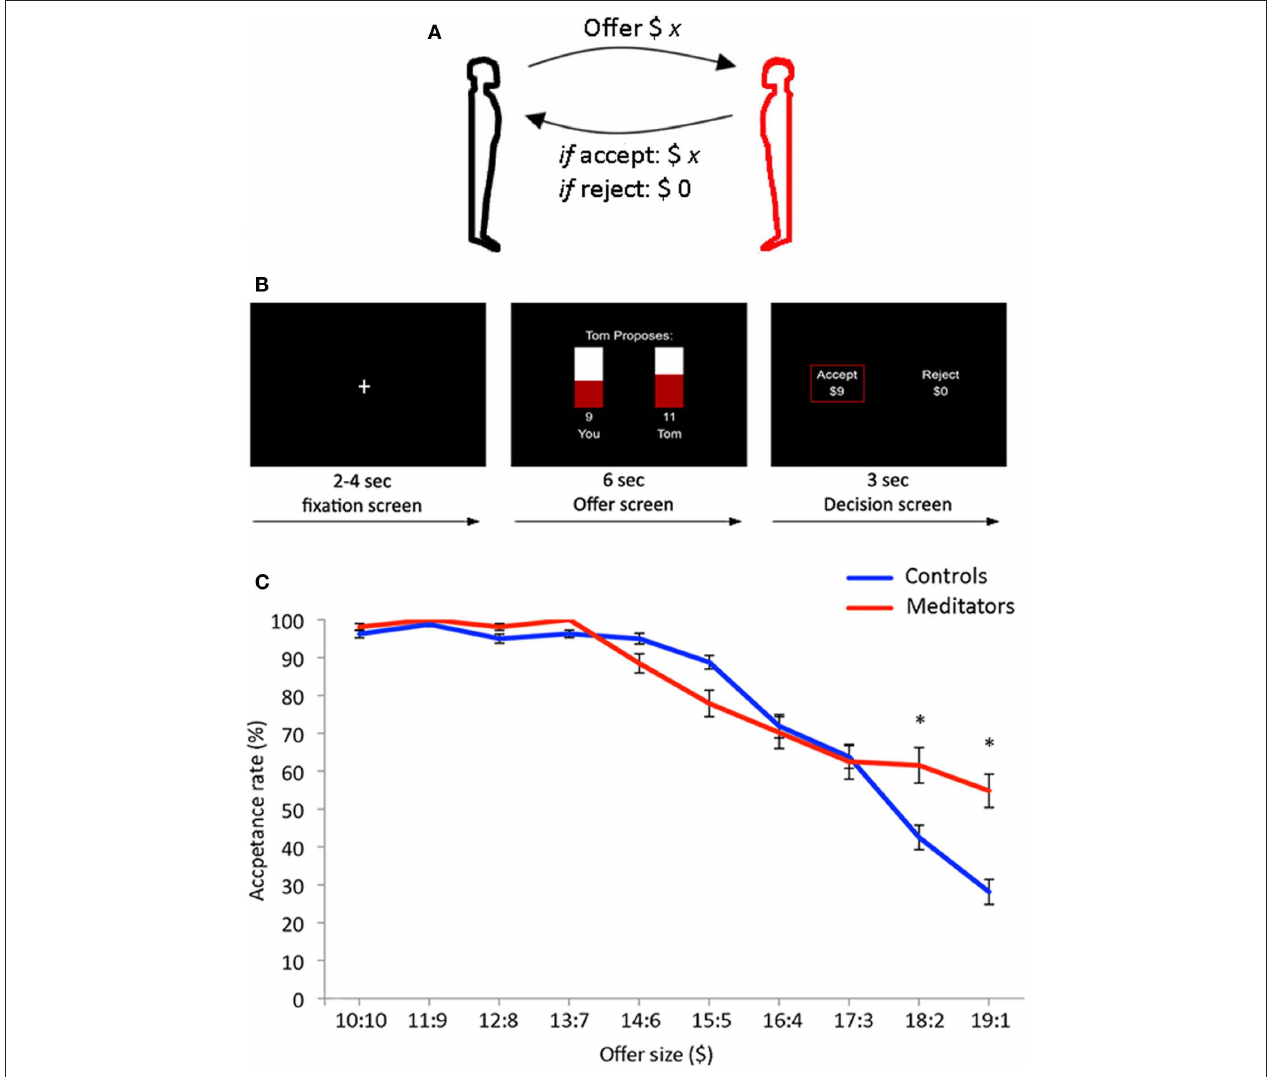
reject the offer (3 s). A red box highlighted the choice being made on each trial. (C) Behavioral results from the Ultimatum Game – meditators (red) displayed significantly higher acceptance rates for the most asymmetric offers from human partners ($19:1 and $18:2) compared to controls (blue). The mean and SEM are